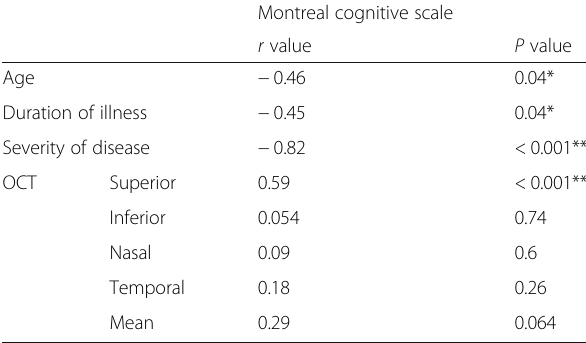
Table 3 Bivariable correlation between cognitive functions and disease parameters in the patients ’ group Montreal cognitive